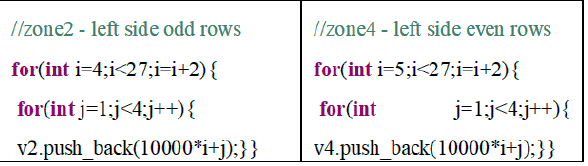
Figure 15. Optimal strategy seat number generation.